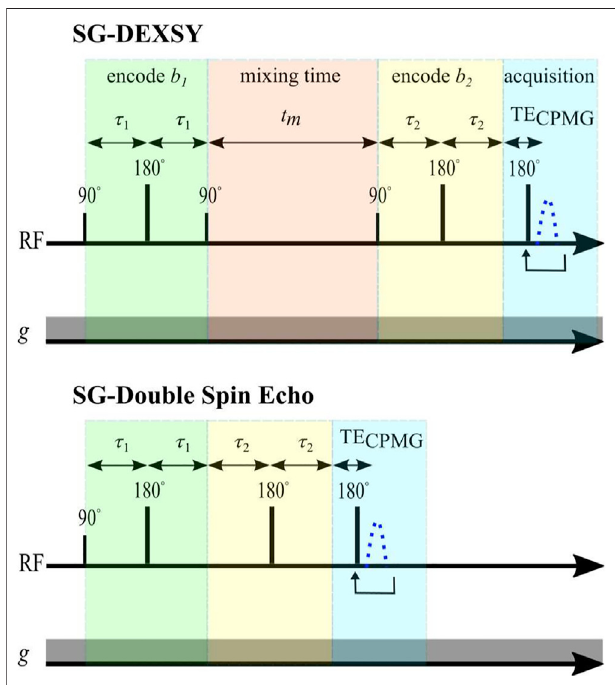
FIGURE4| Pulsesequences. StaticgradientDEXSYandstaticgradient double spin echo pulse sequences implemented on a low- fi eld single-sided NMR